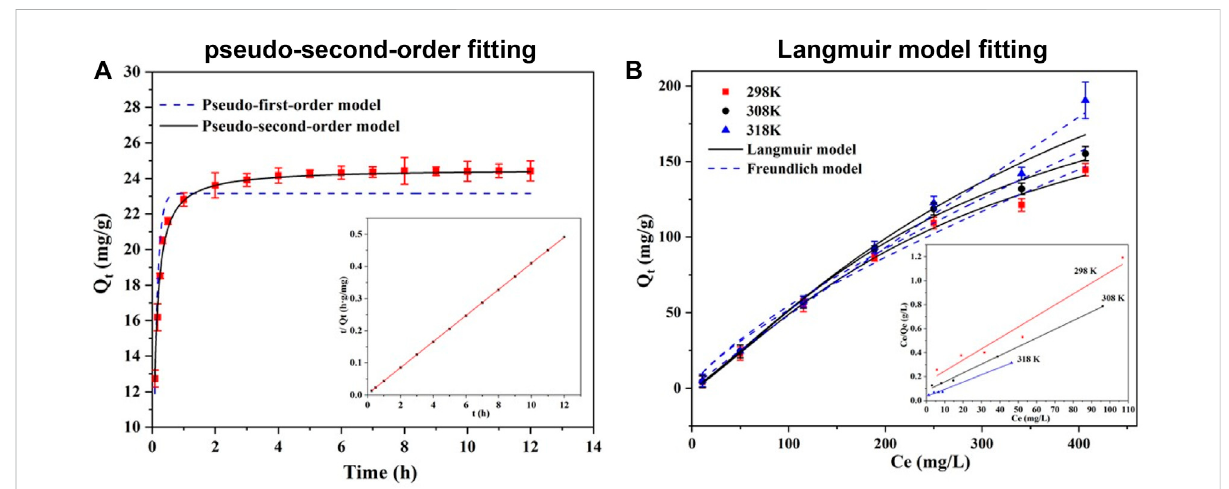
FIGURE 3 Fitting picture of kinetic (A) and isothermal models (B) for the adsorption of Se(IV) by CSBC.